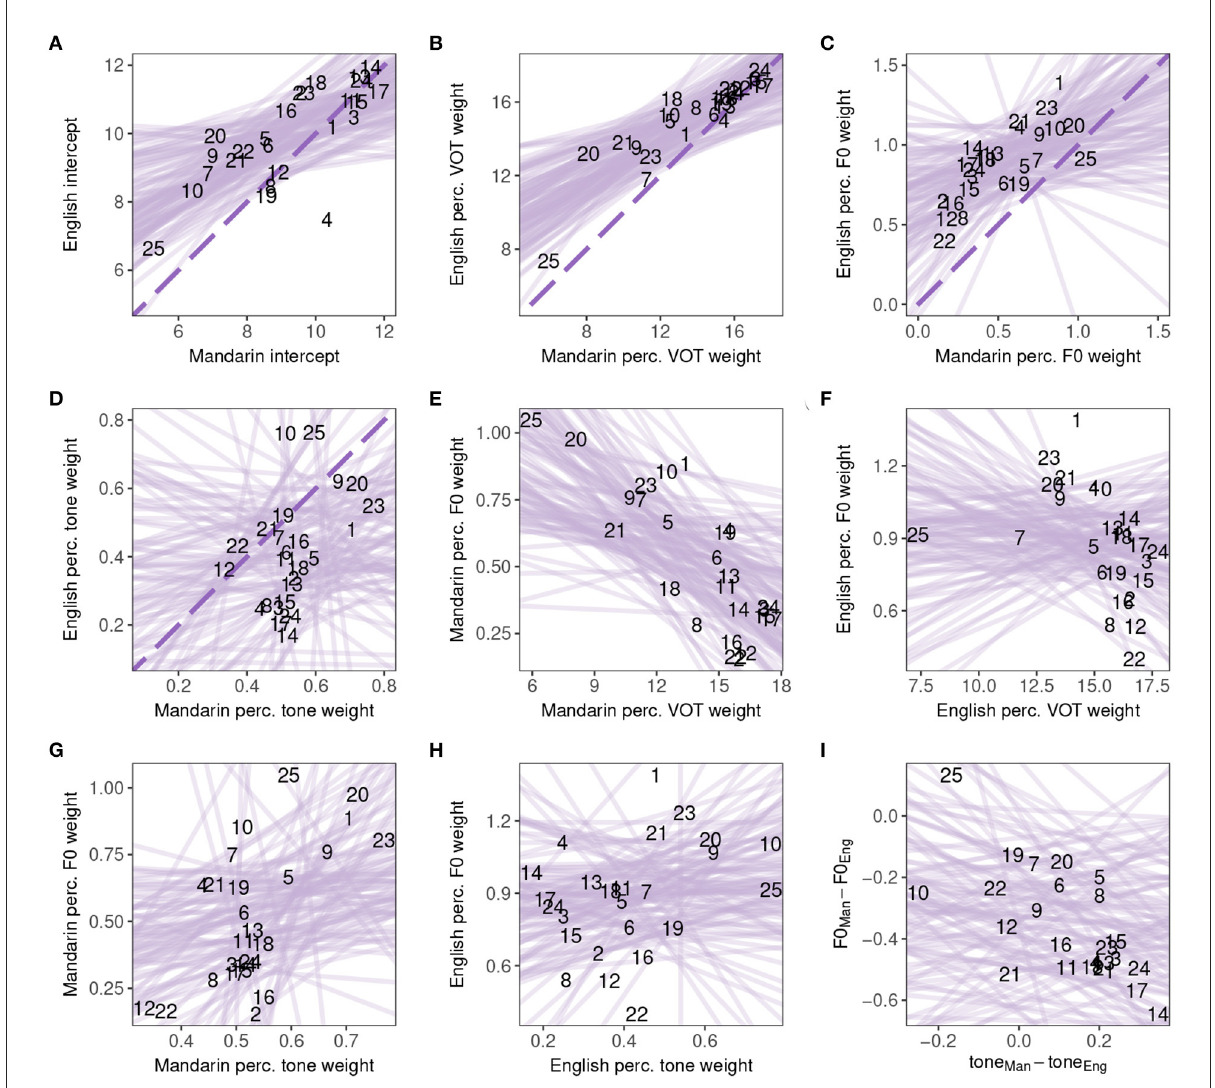
FIGURE8 Scatter plots showing relationships (or lack thereof) between various cues. (A) Intercepts, which are related to category boundaries, across languages. (B) VOT weights across languages. (C) Post-stop F0 weights across languages. (D) Tone weights across languages. (E) F0 vs. VOT in Mandarin. (F) F0 vs. VOT in English. (G) F0 vs. tone in Mandarin. (H) F0 vs. tone in English. (I) Differences in post-stop F0 weights vs. differences in tone weights. Solid lines represent 100 regression lines fitted with 100 posterior draws, to show the direction and uncertainty of the correlation. The dashed line in (A–D) is y = x , where the intercept or VOT / post-stop F0 / tone weight for Mandarin equals that for